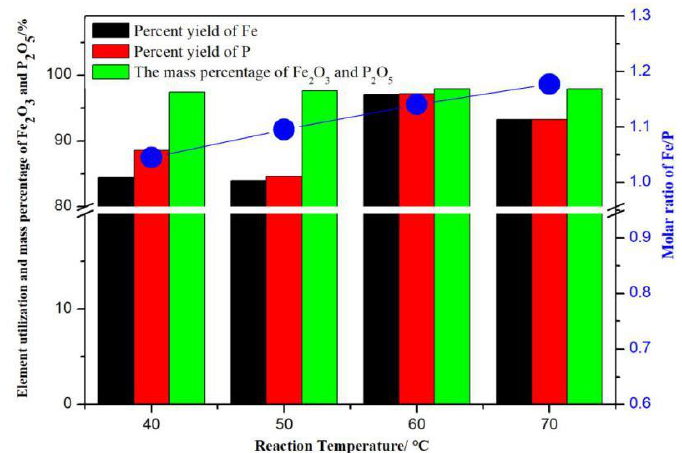
Figure 6. The e ff ect of the reaction temperature on the utilization ratio of the elements / purity and the Figure 6. The effect of the reaction temperature on the utilization ratio of the elements/purity and the molar ratio of Fe / P in iron phosphate. molar ratio of Fe/P in iron phosphate.